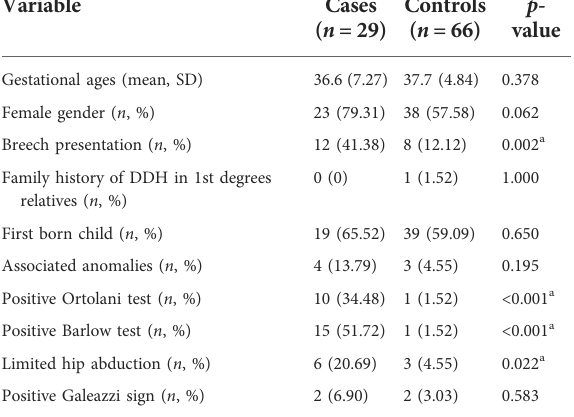
TABLE 3 Univariate logistic analysis and odd